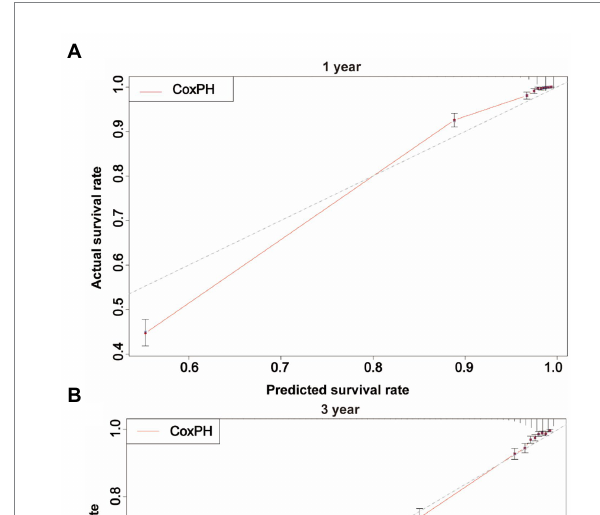
FIGURE 4 The loss change process diagram of training and validating. train_ loss: train loss; Val_loss: validation losss. Train loss is the loss on the training data, which measures the fitting ability of the model on the training set. Val loss is the loss on the validation set, which measures the fitting ability on unseen data.